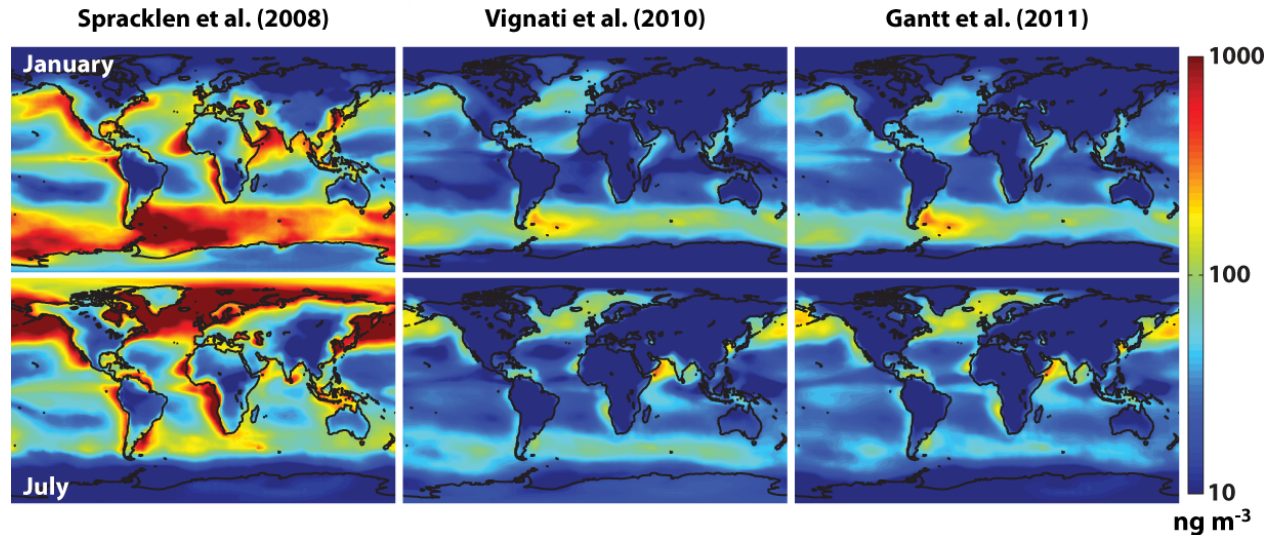
Fig. 2. Average submicron surface concentrations of marine POA in units of ngm − 3 for January (top row) and July (bottom row) from the Spracklen et al. (2008), Vignati et al. (2010), and Gantt et al. (2011) emission